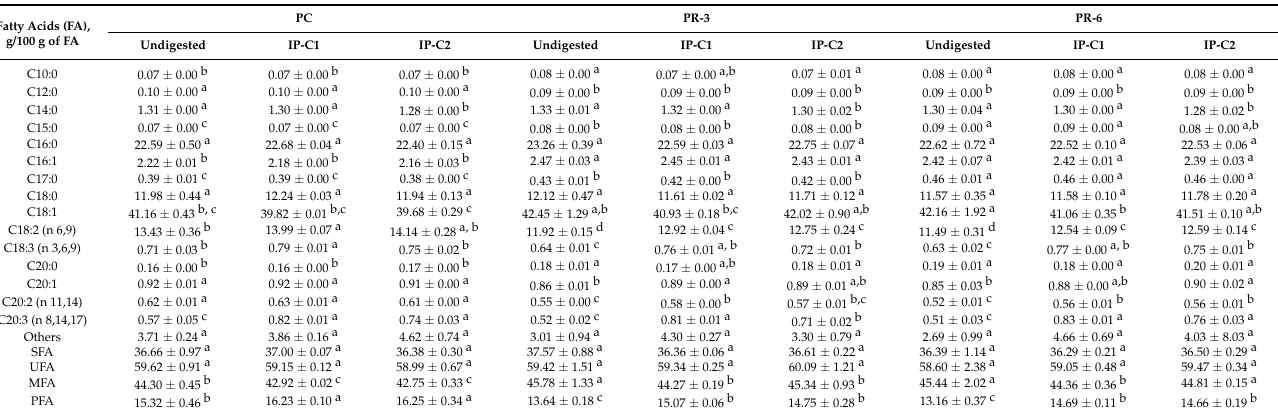
Table 6. Fatty acid profile of the undigested and digested pork liver pâté samples.